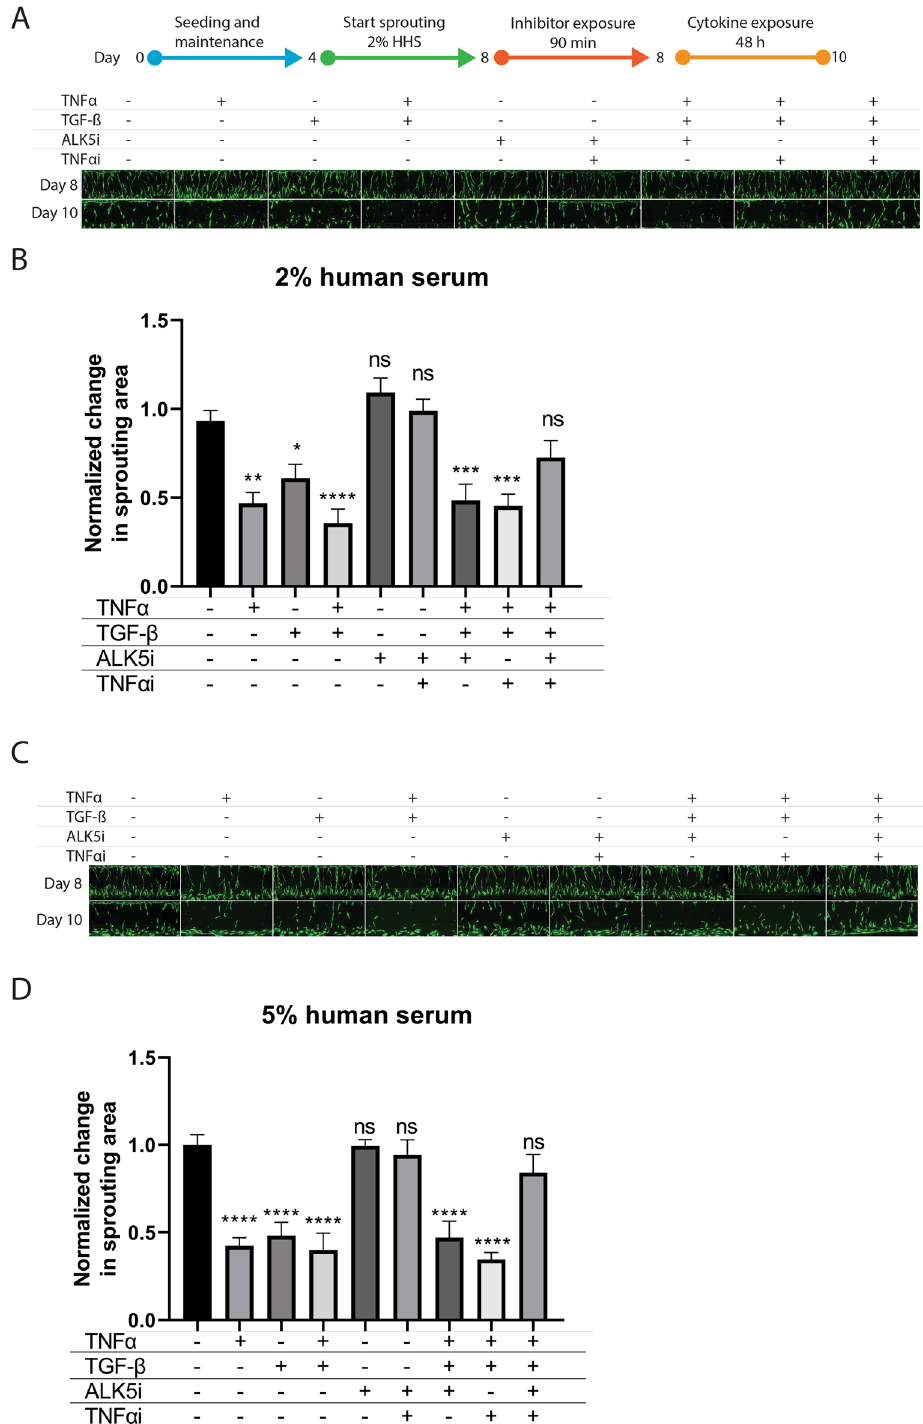
Figure 3. Response of the sprouted microvessels to cytokines and inhibitors. Sprouted microvessels were preincubated on day 8 with ALK5i or TNFα iAB for 90 min and subsequently exposed to (a combination of) TNFα or TGFß for 48 h in 2% (panel A and B ) or 5% (panel C and D ) human serum. ( A ) and ( C ) show representative images of cultures exposed to (a combination of) inhibitors and cytokines. ( B ) and ( D ) show quantification plots of the area covered by sprouts of exposed microvessels after exposure. The ratio of the sprouting area before and after the stability assay was normalized to the no exposure condition. n = 7–12, shown is the mean ± SEM, statistical test – ordinary one-way ANOVA (ns = not significant, * p < 0.05, ** p < 0.01, *** p < 0.001, **** p <